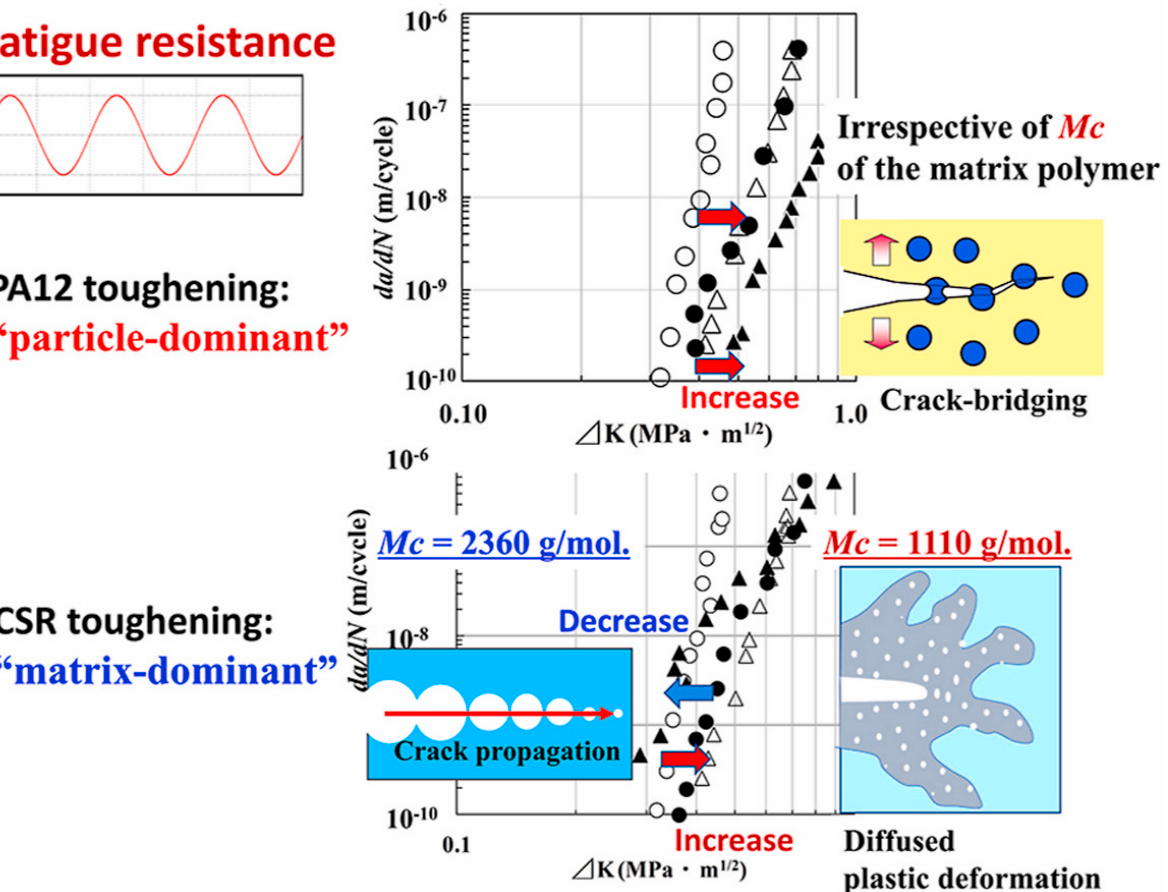
Figure 36. An exemplary illustration of the fatigue crack propagation (FCP) and fatigue threshold of moderately and highly toughened epoxy blends with PA12 and CSR polymer particles, adapted with permission from Ref. [120]. Copyright © 2021 Elsevier